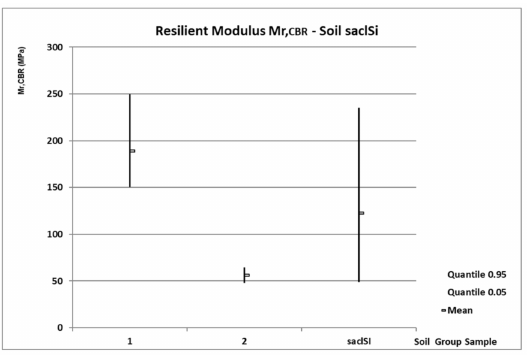
Figure 3. Statistical quantities—mean, 0.05 quantile, 0.95 quantile of M r,CBR for saclSi